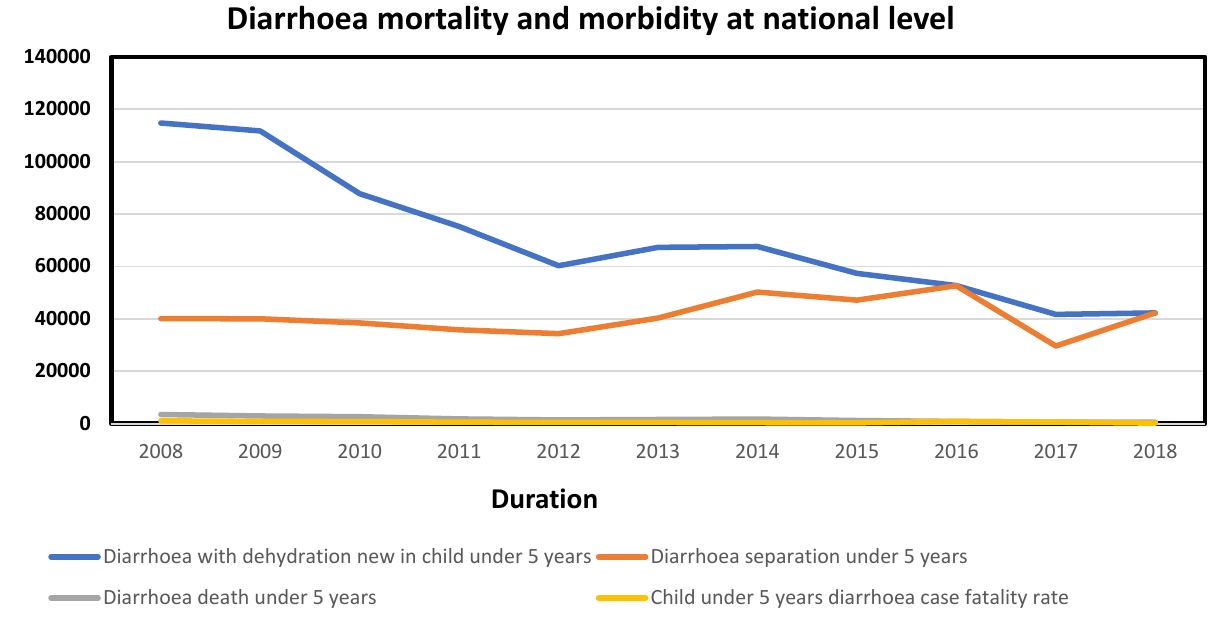
Figure 3. Diarrhoea morbidity and mortality of children under the age of five years. Figure 3 indicates the health outcomes sustained by children under the age of five years in South Africa from 2008 to 2018. Diarrhoea separation, diarrhoea deaths, case fatalities, and diarrhoea with dehydration new cases in children under five years old in South Africa were showcased in different quantities for the duration of 2008 to 2018.